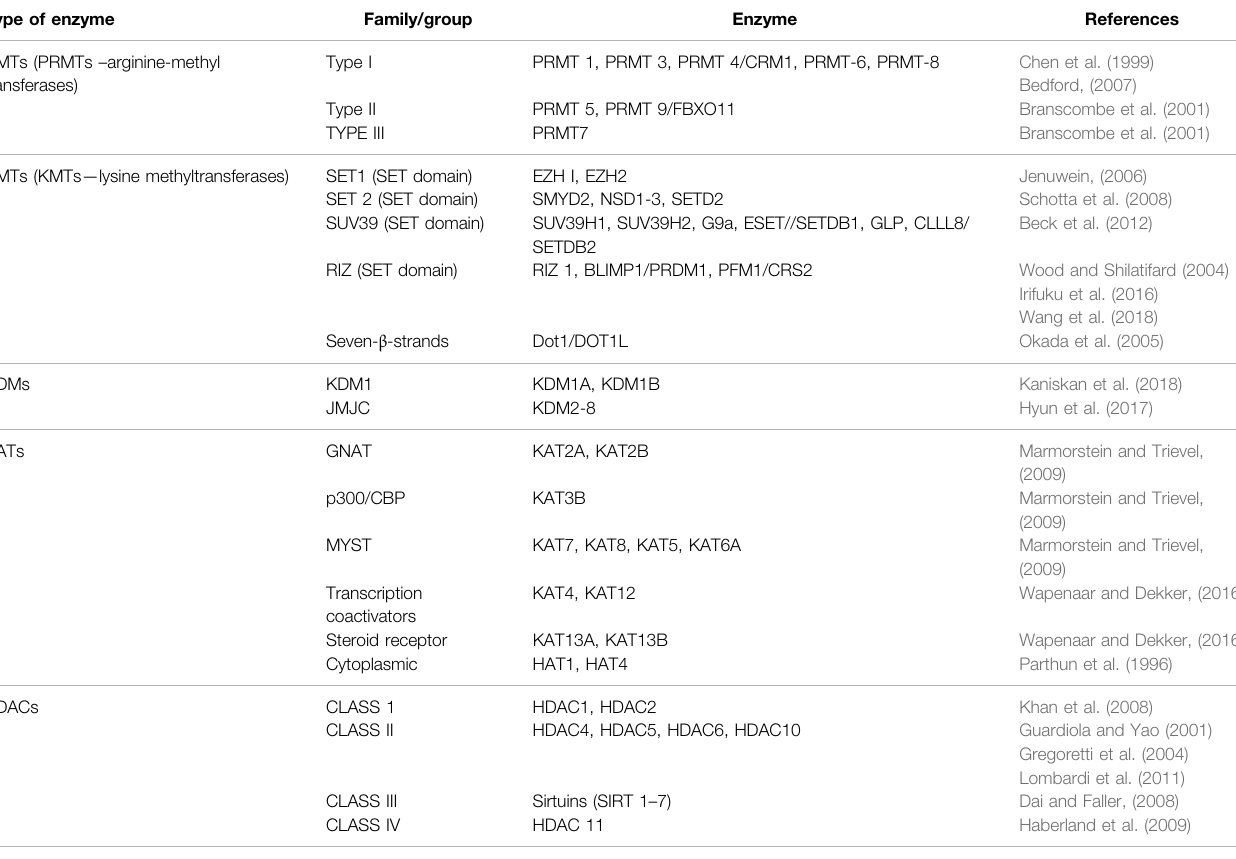
TABLE 2 | Various classes and subtypes of enzymes that mediate histone methylation and acetylation.